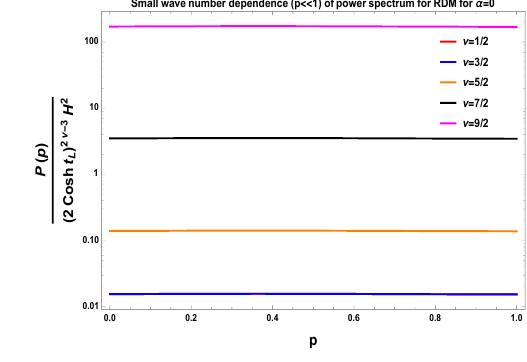
( b ) Small wave number dependence of RDM power spectrum for α = 0 and ν = 1/2,3/2,5/2,7/2,9/2.